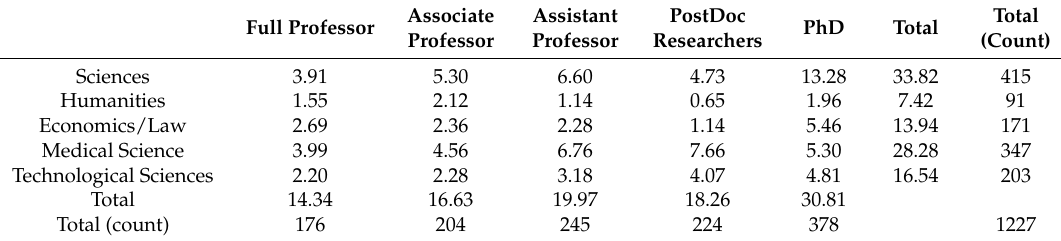
Table 2. Total staff on the 31 December 2010